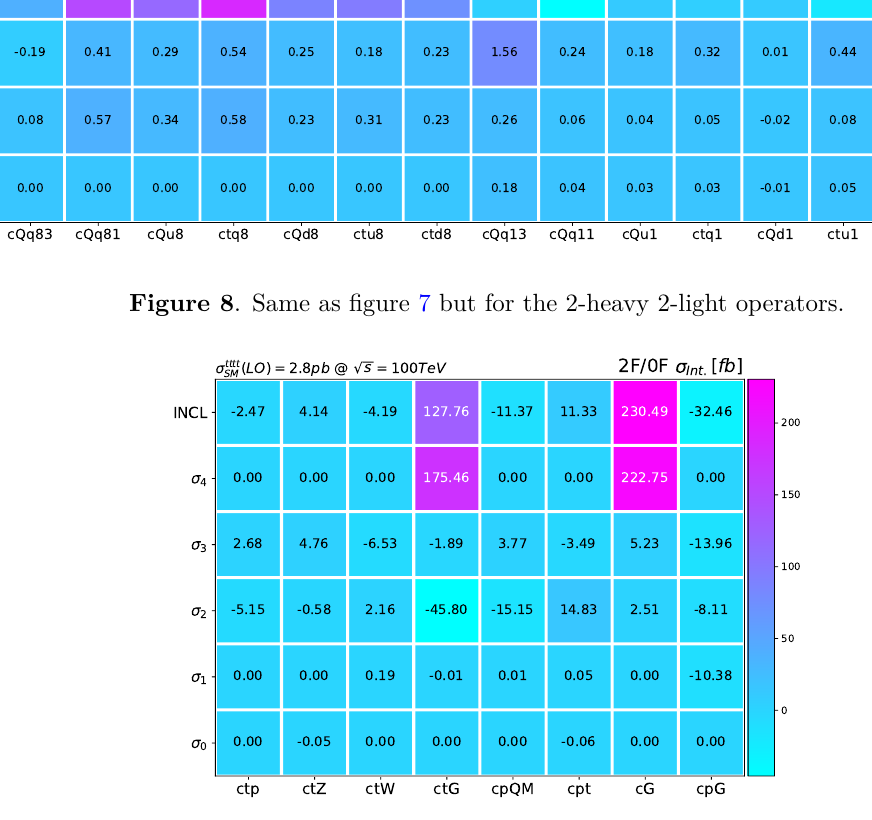
Figure 9 . Same as figure 7 but for the contributing